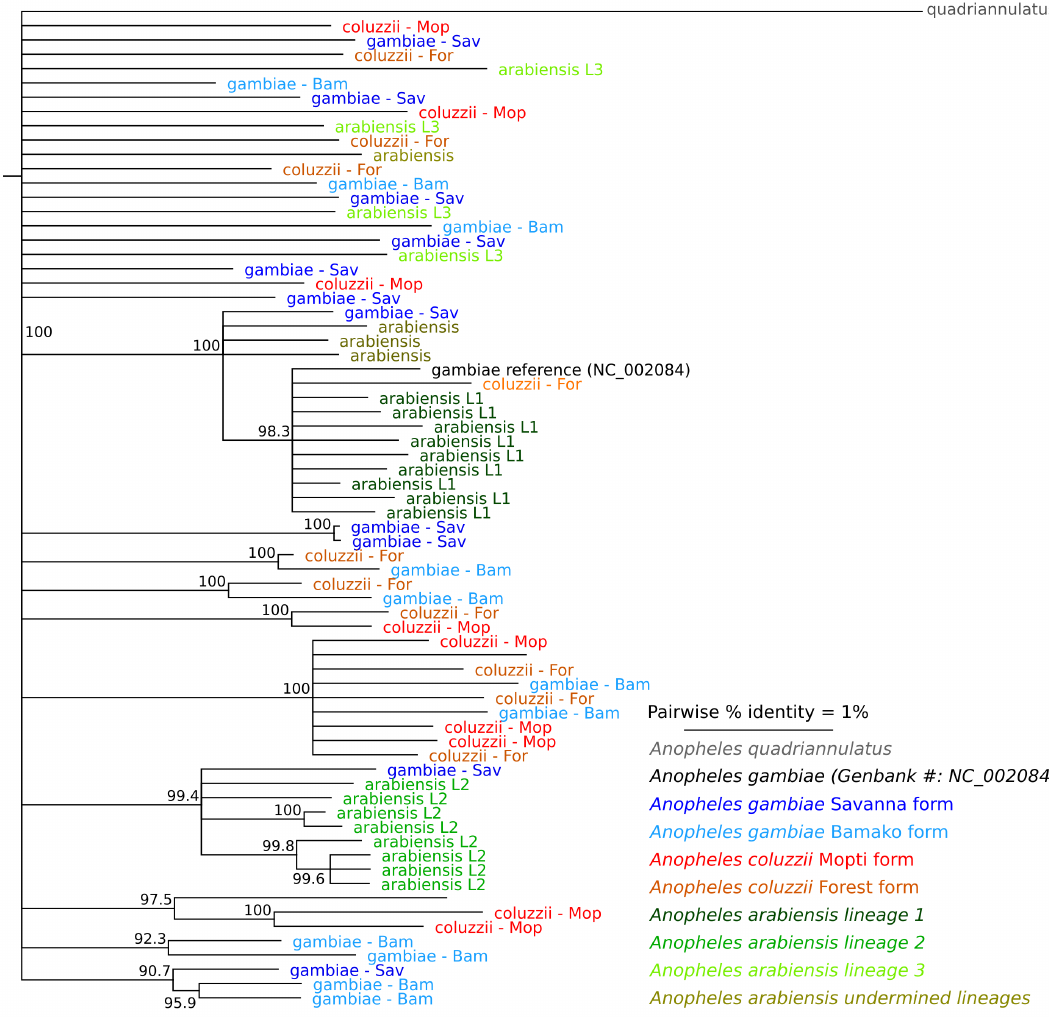
Figure 1. Phylogenetic tree inferred from mtDNA genome sequence data. The phylogenetic tree fails to reveal a clear division of the operational taxonomic units included in this analysis. Colors indicate the species or chromosomal form and numbers at the branches indicate the accuracy of the inferred branches on a scale of 0–1, where 1 represents the highest confidence. The three An. arabiensi s lineages are previously reported by Maliti and co-workers (Maliti et al .,